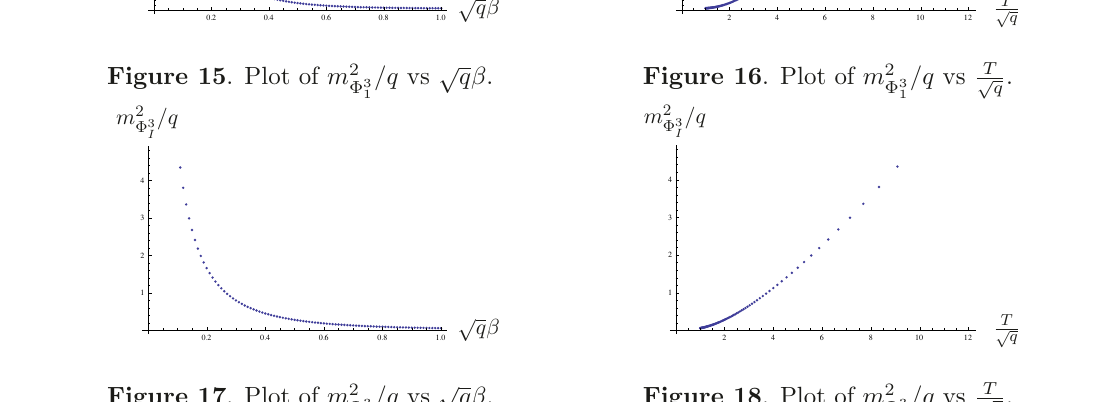
/q vs √ qβ . Figure 18 . Plot of m 2 Φ 3 I